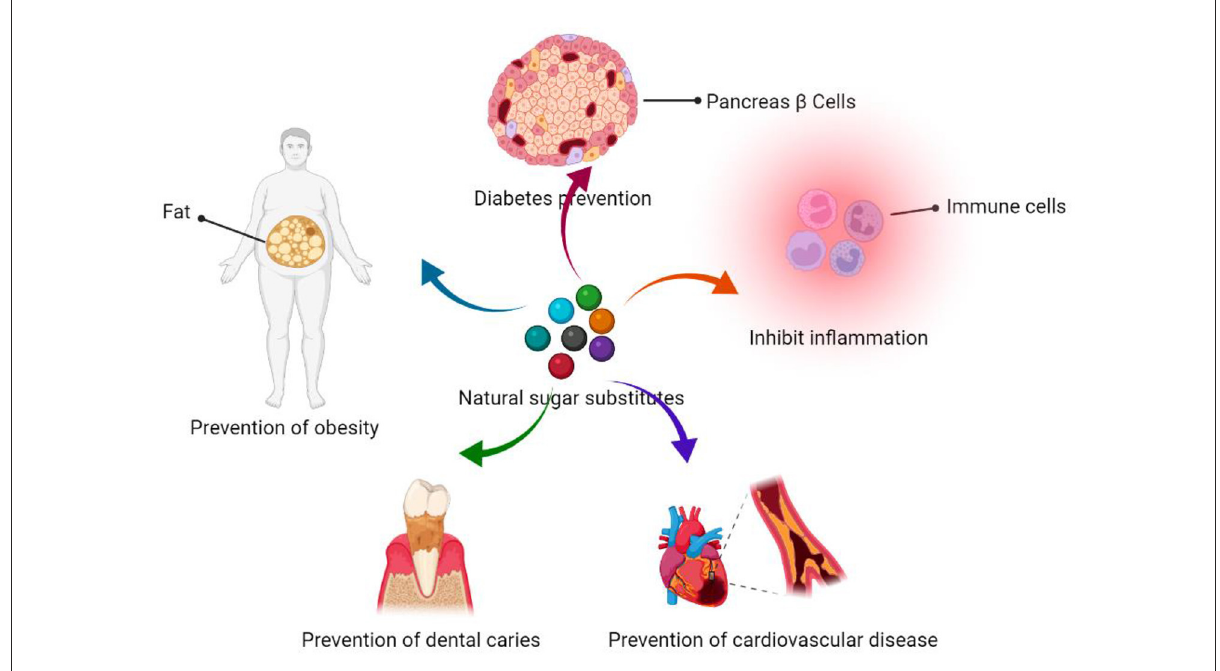
FIGURE6 Schematic representation of the biomedical function of NSS.